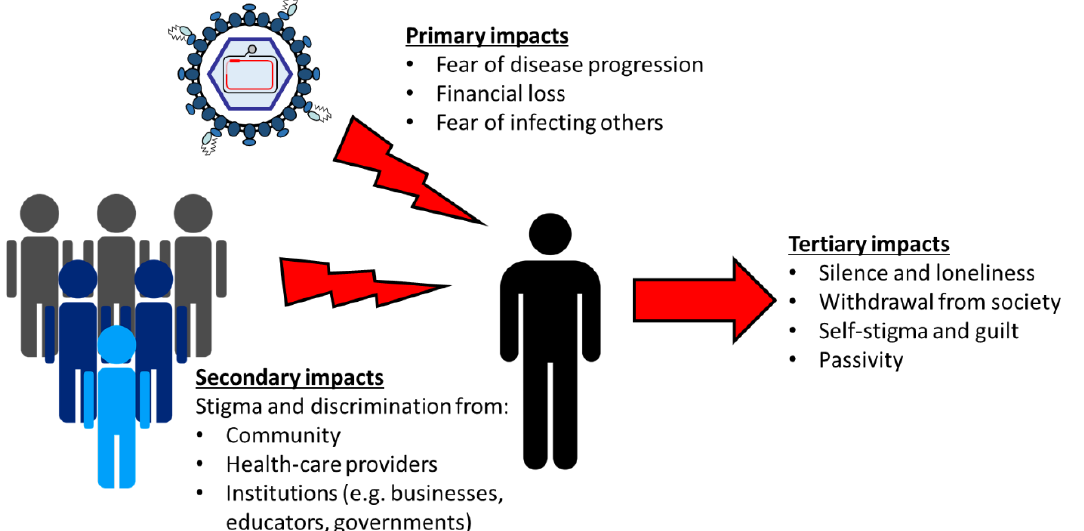
Figure 1. An overview of the psychosocial impacts of HBV infection on an individual living with CHB.